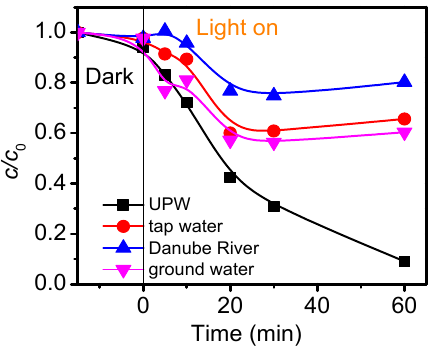
Figure 9. Efficiency of FB 1 (1.39 μ mol/dm 3 ) removal in different types of water using ZS–2 photo ‐ catalyst (1 mg/cm 3 ) using UV irradiation at pH~8. alyst (1 mg/cm 3 ) using UV irradiation at